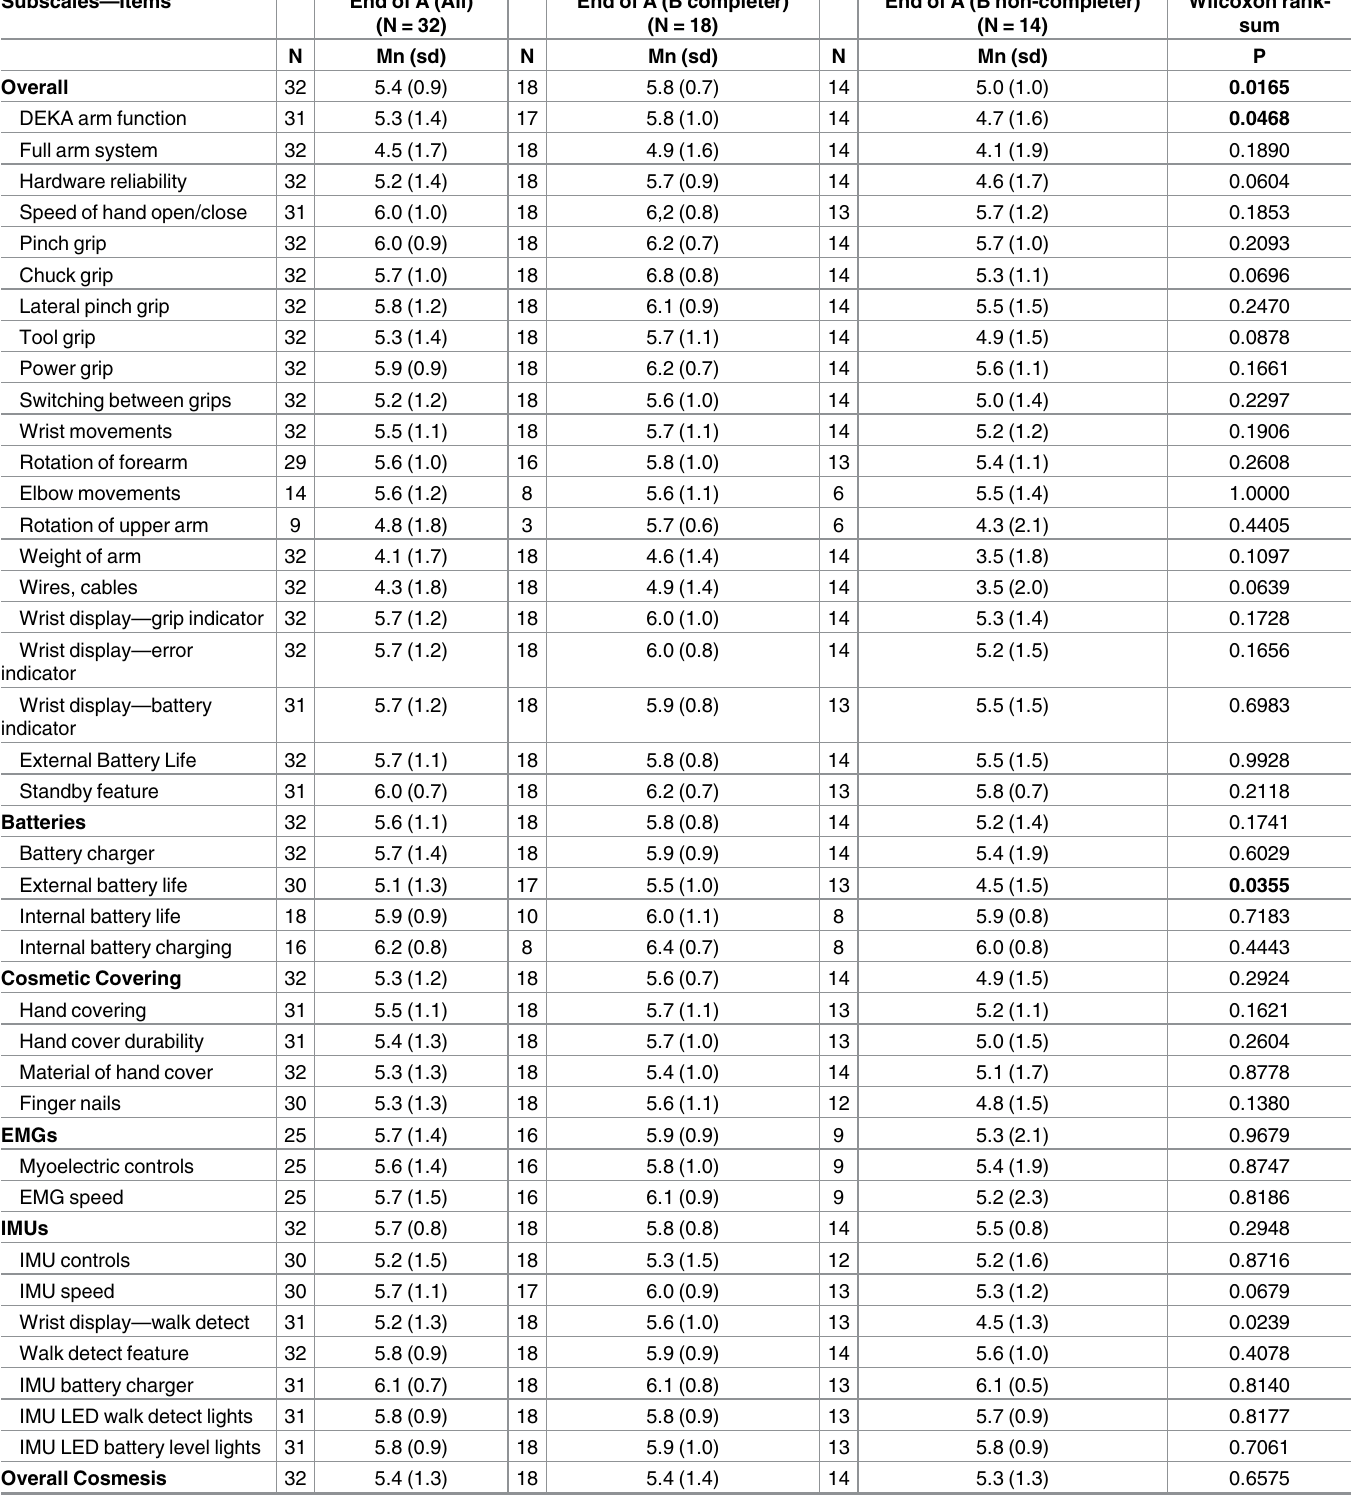
Table 6. Satisfaction subscales and item scores for participants who completed only Part A and those who completed Part A and Part B.